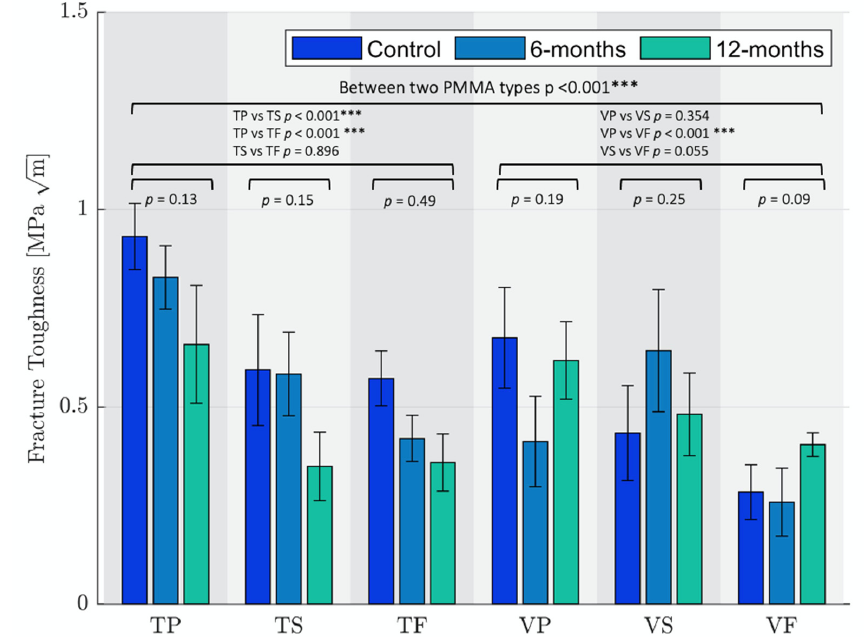
Figure 3. Fracture toughness of all sample groups representing control, 6 months and 12 months. The vertical lines represent 95% Confidence Interval ranges for Tukey’s pairwise comparisons. *** indicates a statistical significance level p < 0.001.